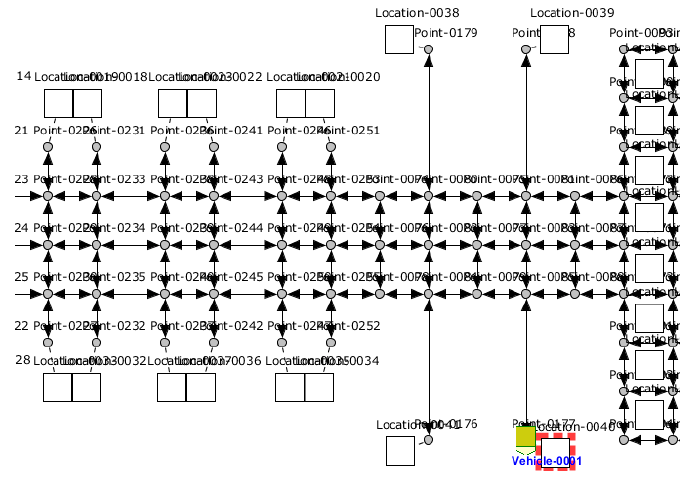
Figure 13. Task success. Figure 12. Paths planned by the first-level path planning algorithm. Figure 14. Task success. Figure 13. AGV status during operation.